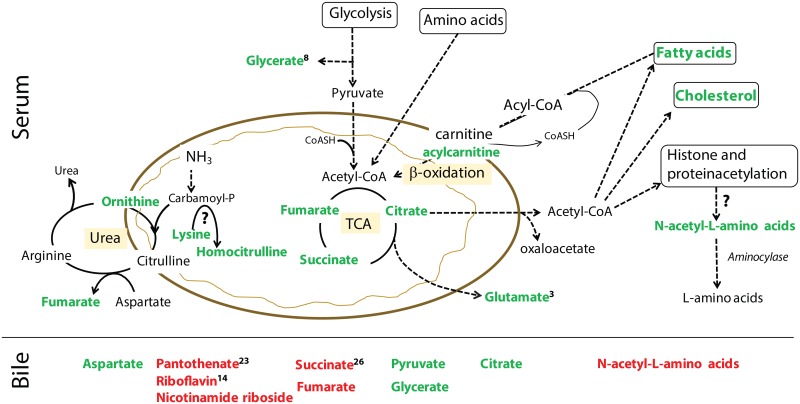
Hypothetical points of intersection of significantly altered compounds with carbon, nitrogen, and energy metabolism in dogs with gallbladder mucocele formation.Top of Fig represents compounds identified in serum and bottom of Fig represents compounds identified in bile. Compounds in green font were increased and compounds in red font were decreased in dogs with gallbladder mucocele formation in comparison to control dogs. Superscript numbers, when present, indicate rank of the compound as identified by Random Forest analysis as able to distinguish between control dogs and dogs with gallbladder mucocele formation. TCA, tricarboxylic acid cycle.